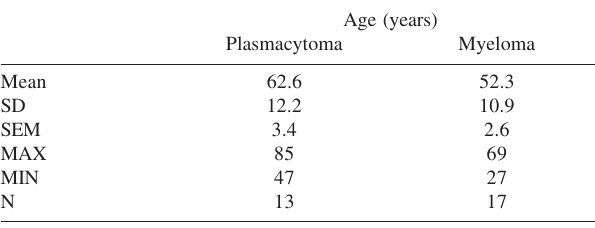
Figure 5 - Survival time (months) in patients with plasmacytoma and in patients with plasmacytoma that progressed to multiple myeloma (descriptive statistics)